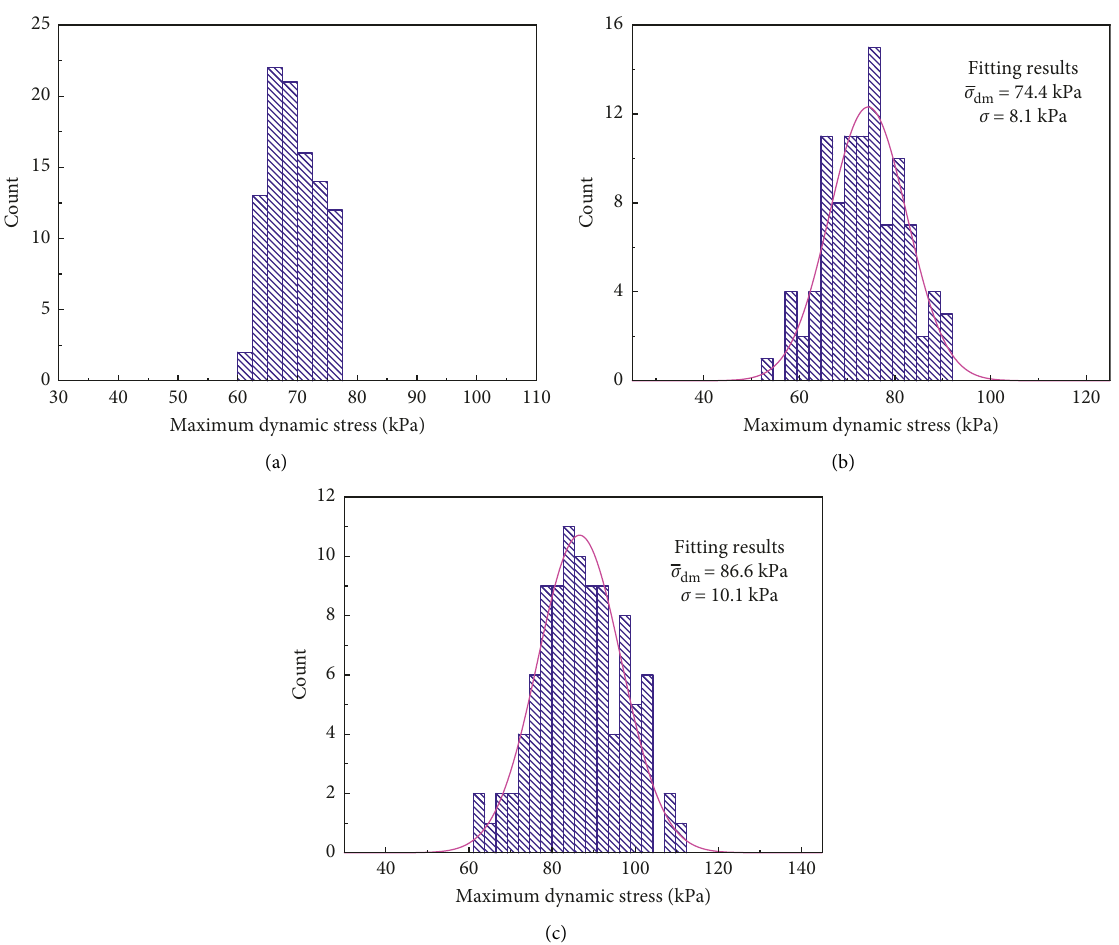
Figure 18: Statistical graph of the maximum dynamic stress at the subgrade surface: (a) smooth rail; (b) irregularity in China’s three main lines; (c) heavy-haul track irregularity.